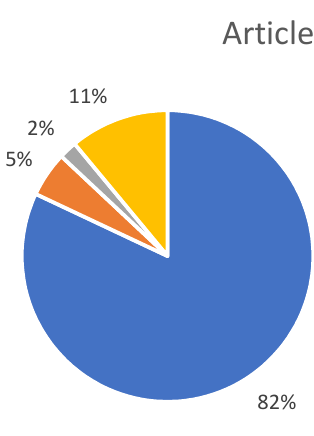
Figure 2. Type of Figure 2. Type of Articles. Figure 2. Type of Articles.